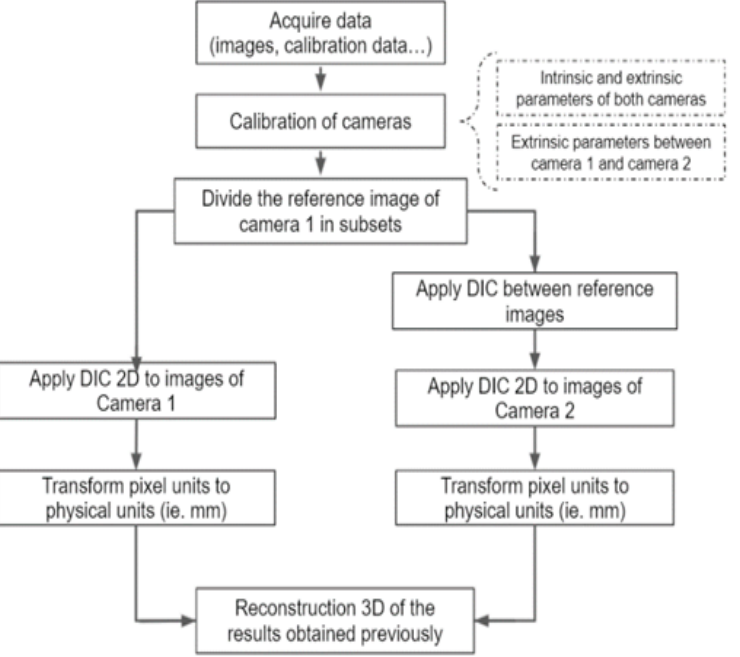
Figure 3. Structural characterization with the projected 3D‑DIC configuration (schematic